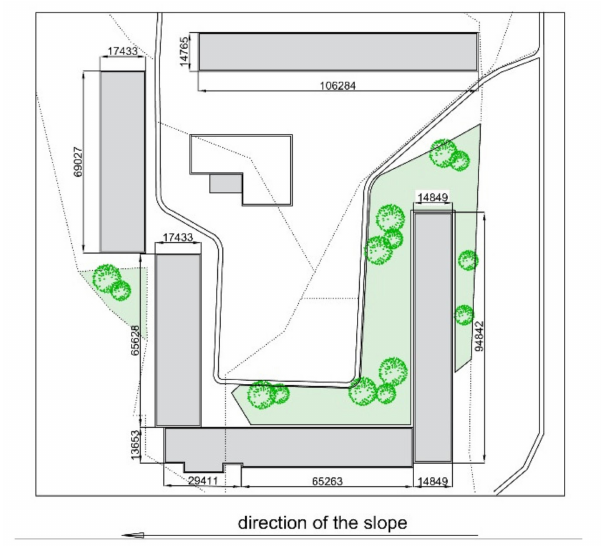
Figure 8. Real residential perimeter block in Murmansk city.